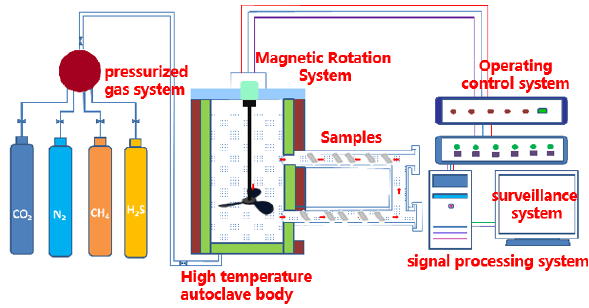
Figure 2. Schematic of the HTHP autoclave.